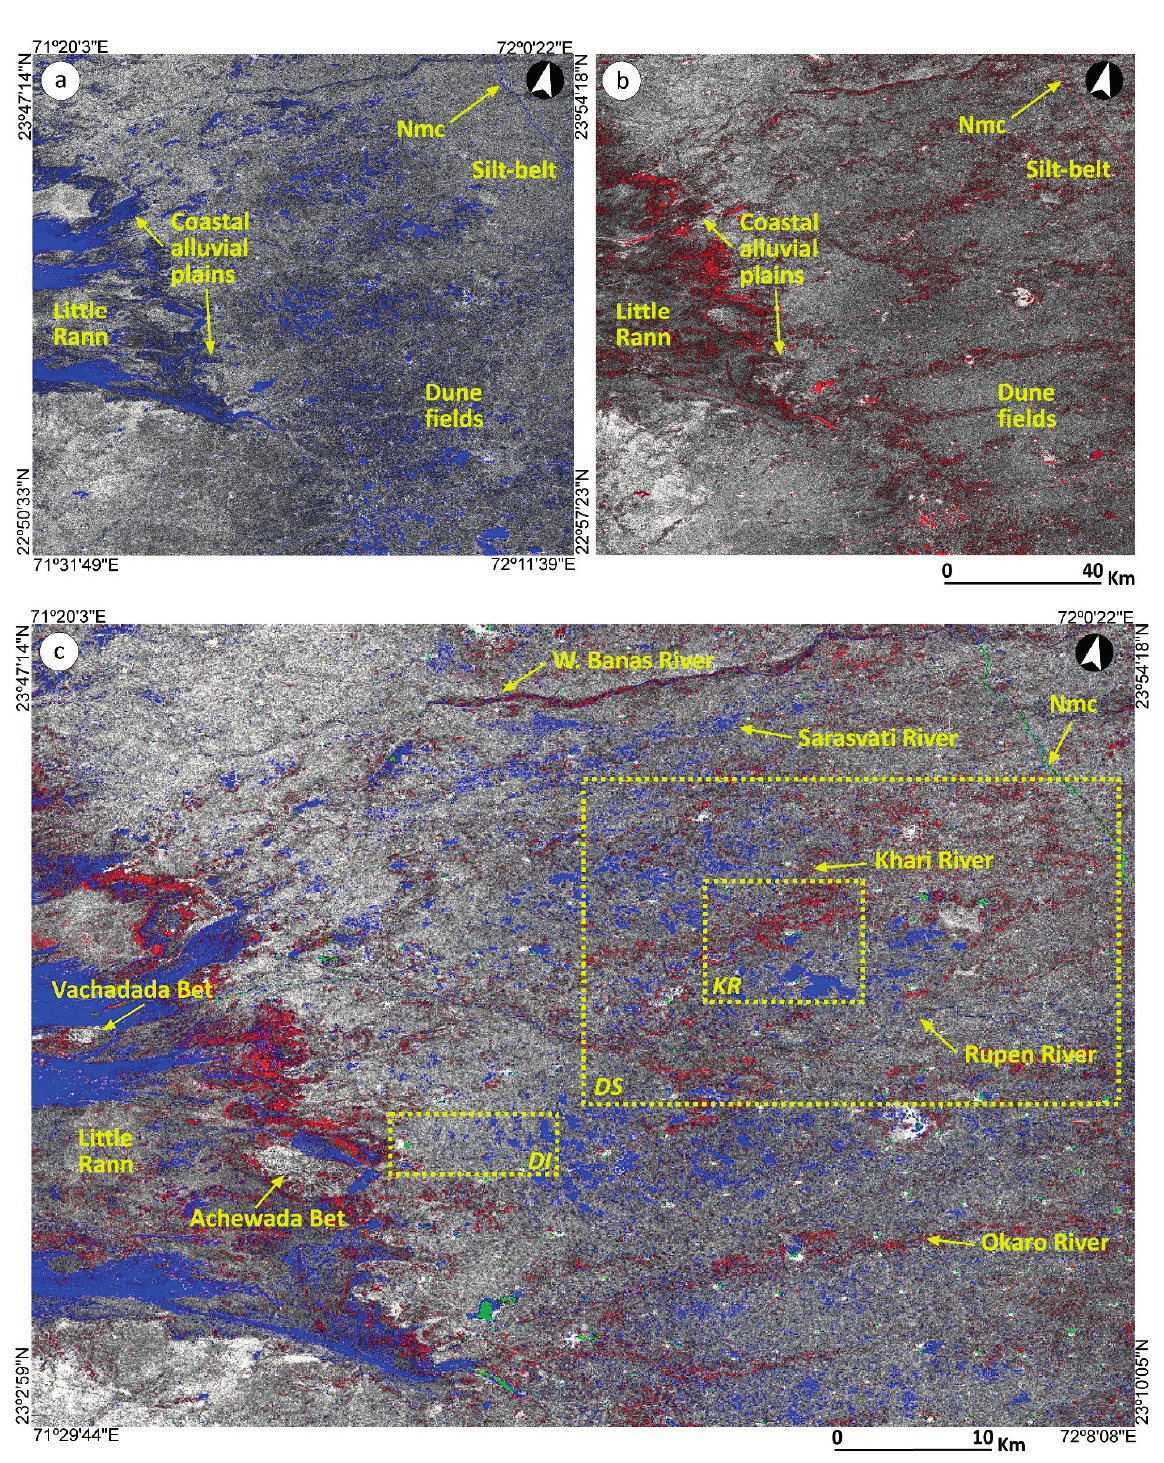
Figure 6. ( a ) Monsoonal flooding map (enhanced in blue) superimposed to monsoonal MA and ( b ) post-monsoonal flooding map (enhanced in red) superimposed to post-monsoonal MA; ( c ) Integrated seasonal flooding map. Pixels flooded on both seasons are represented in green. Dotted areas indicate the subsets of interest displayed in Figure 7 (KR), Figure 8 (DI) and Figure 9c